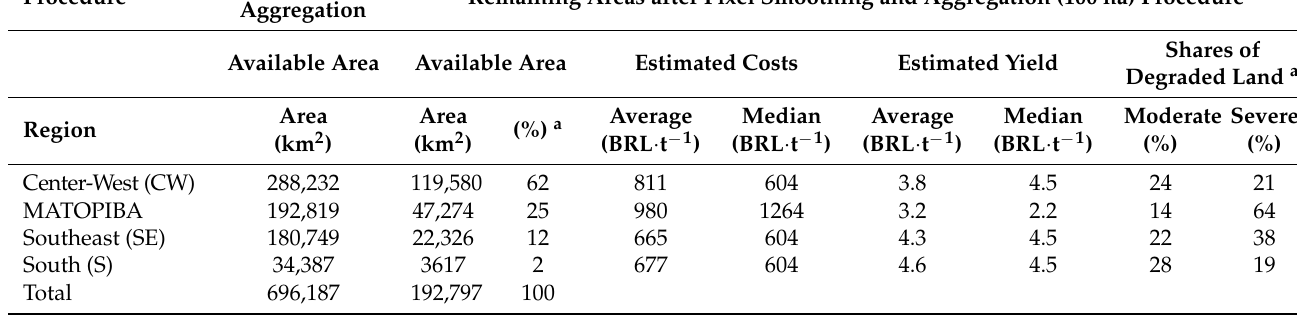
Table 3. Available area for soy expansion after imposing restrictions, information about the average estimated costs and yields, and share of degraded pasturelands, by level of degradation.